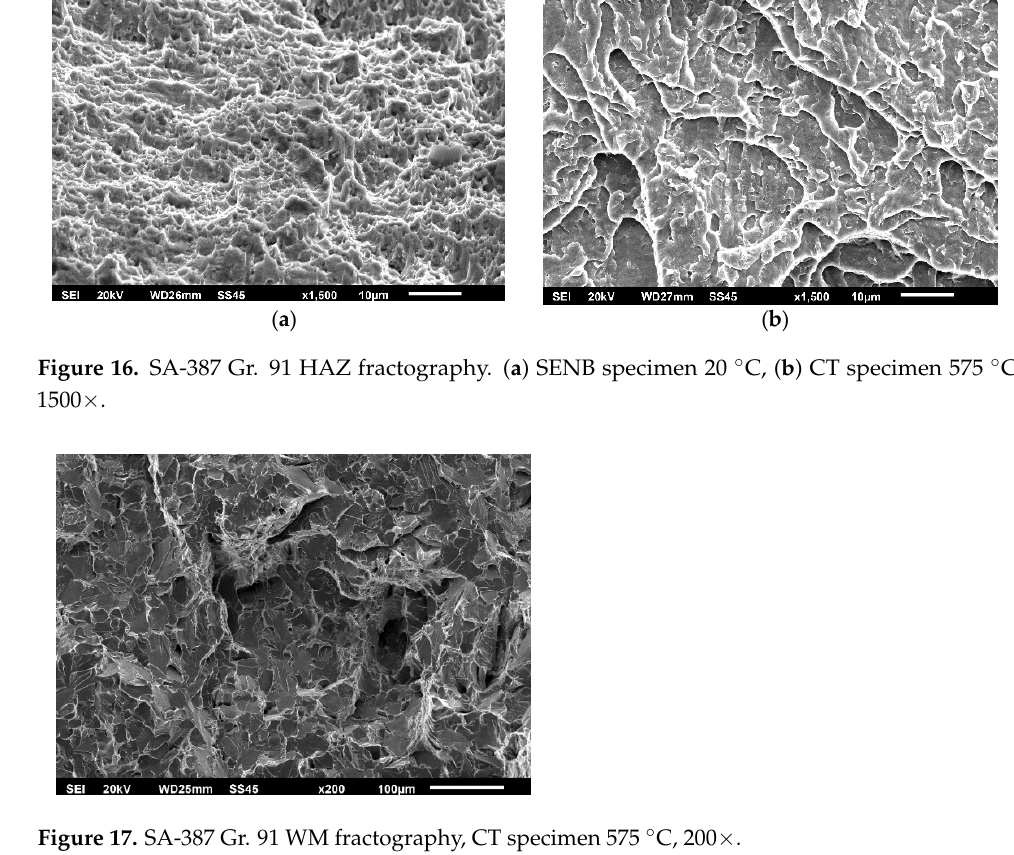
Figure 15. SA ‐ 387 Gr. 91 BM fractography. ( a ) SENB specimen 20 °C, ( b ) CT specimen 575 °C, 1500×.